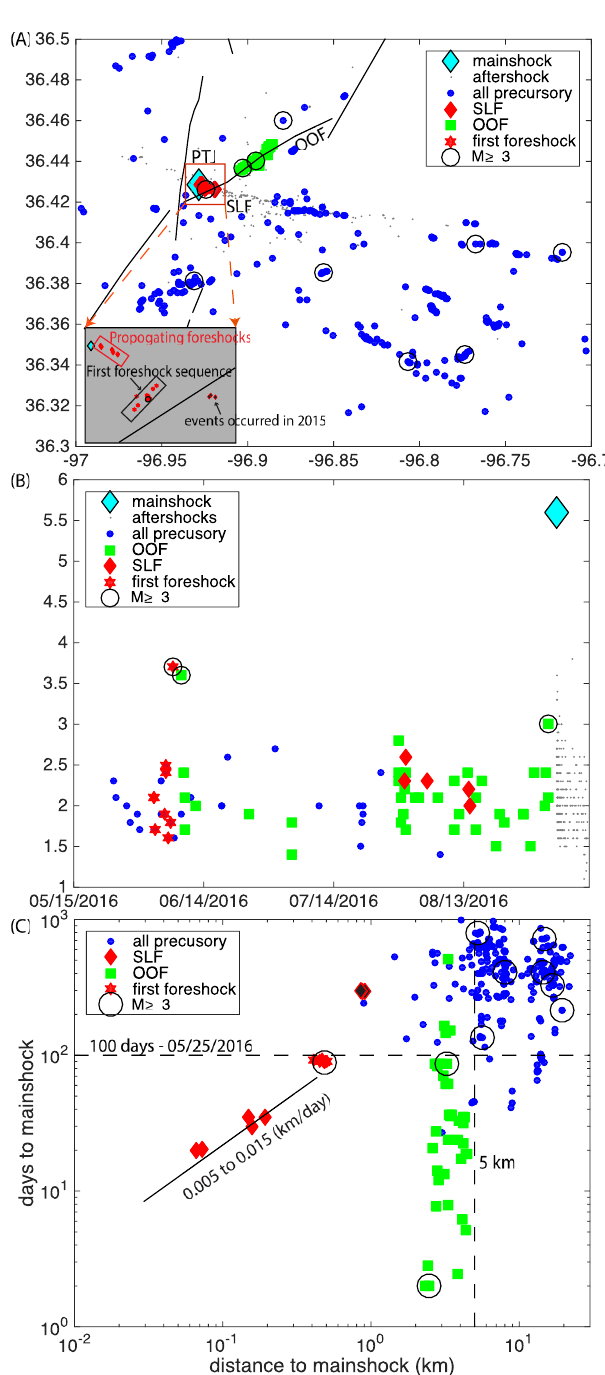
Figure 5. Foreshock migration leading to the mainshock. ( a ) Map view of foreshock and other background seismicity in this area. Earthquakes belong to different clusters are denoted with different symbols (see Map legend). The inset shows zoomed in view of the foreshock activities near PTJ, the first foreshock sequence and the foreshocks propagating to mainshock are enclosed in black and red boxes, respectively. Black lines show mapped faults, and black circles show events with M ≥ 3 that occurred before the mainshock. ( b ) Magnitude versus time for the 200 days period before mainshock. See legend for symbols. ( c ) Days to mainshock versus distance to mainshock. Note the apparent foreshock propagation within 0.5 km of the mainshock. The apparent migration velocity leading to the mainshock is between 0.005 to 0.15 km/day. The black diamonds with red outlines are three M1 events occurred west of OOF in 2015, which are not included in figure ( b